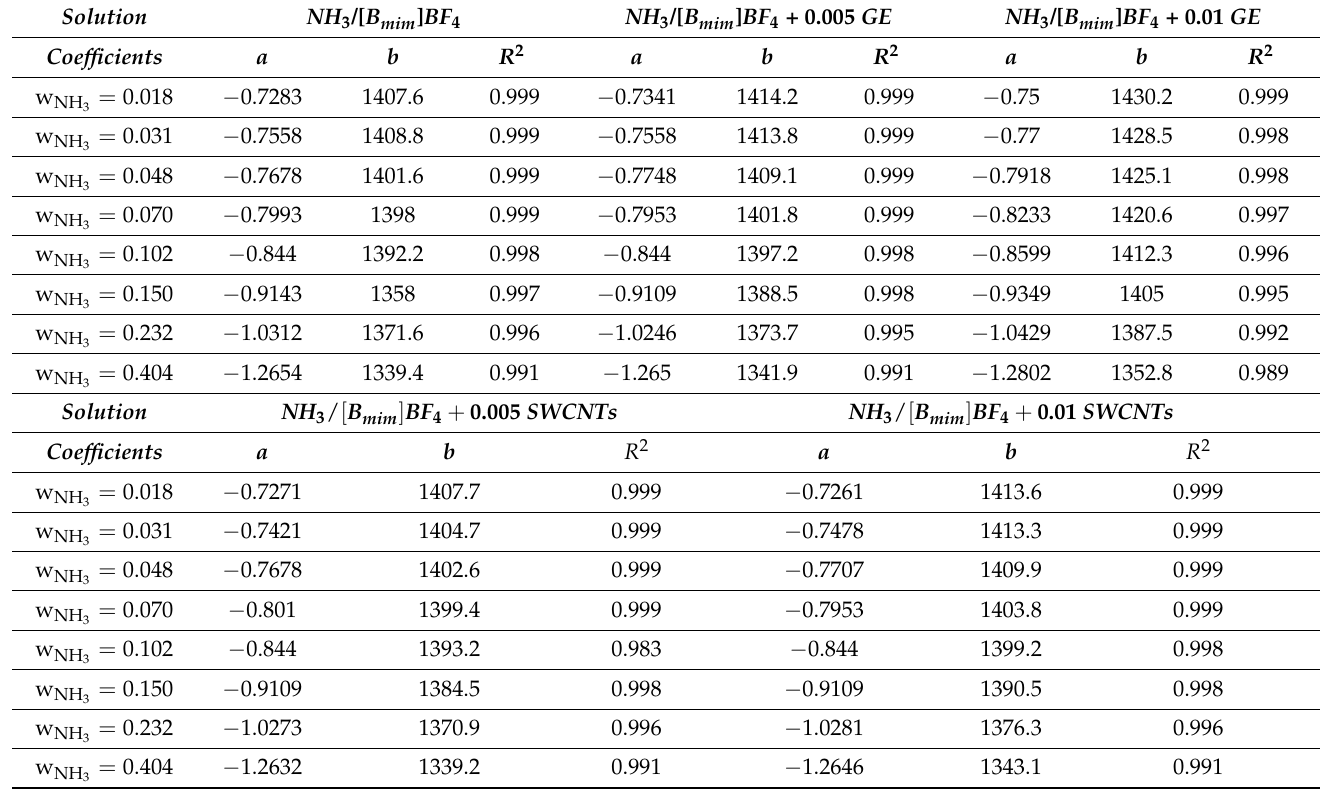
Table 9. Coefficient values a , b , and R 2 obtained by fitting Equation (7).